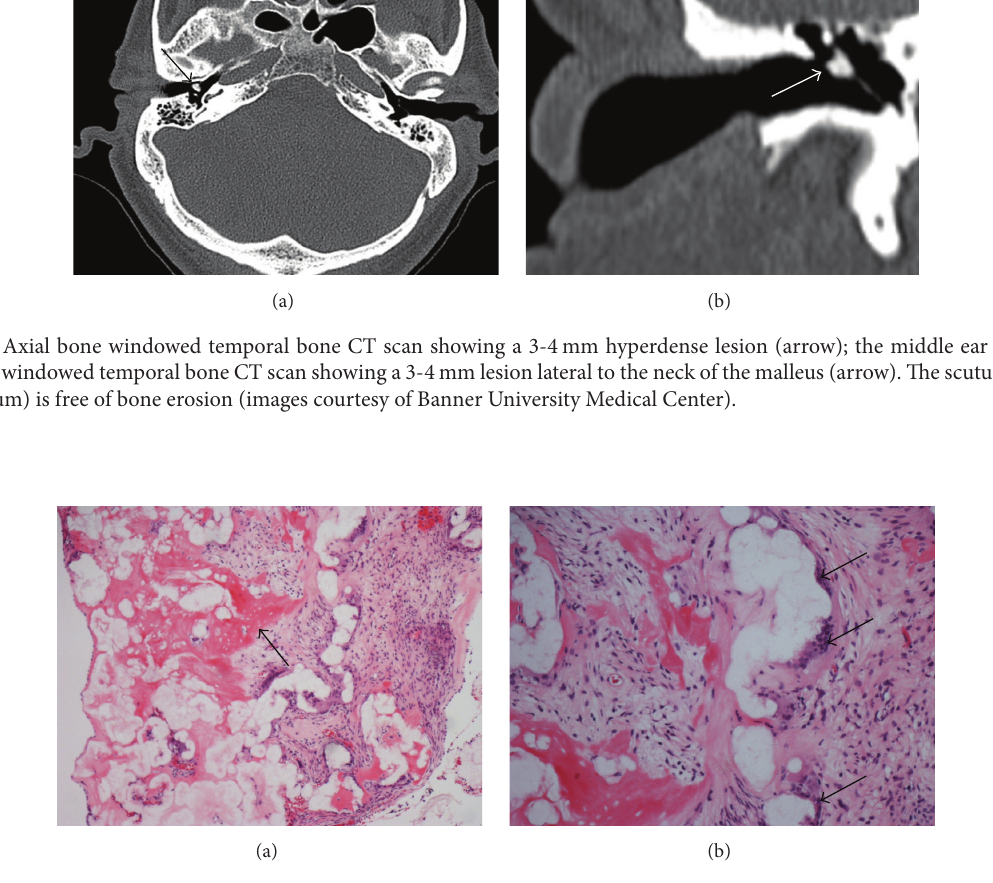
Figure 3: (a) Hematoxylin and eosin stained light microscopy obtained from the right ear mass (10x). Fibrous infiltrate, hyaline degeneration, and calcification (arrow) without presence of squamous epithelium are seen. (b) 20x view with black arrows demonstrating giant cell reaction (images courtesy of Sarah Tang,